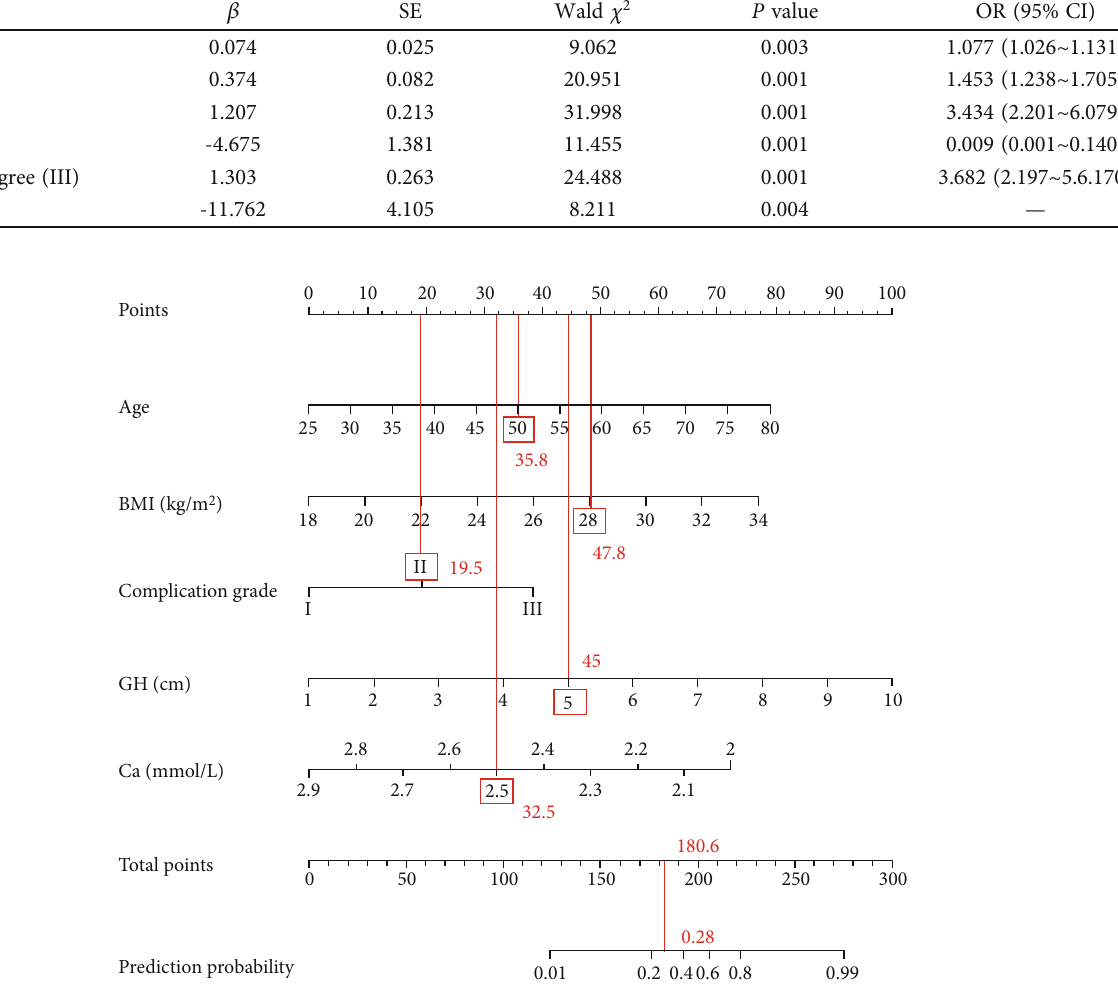
Table 2: Multivariate logistic regression analysis on the in fl uence of POP postoperative recurrence.